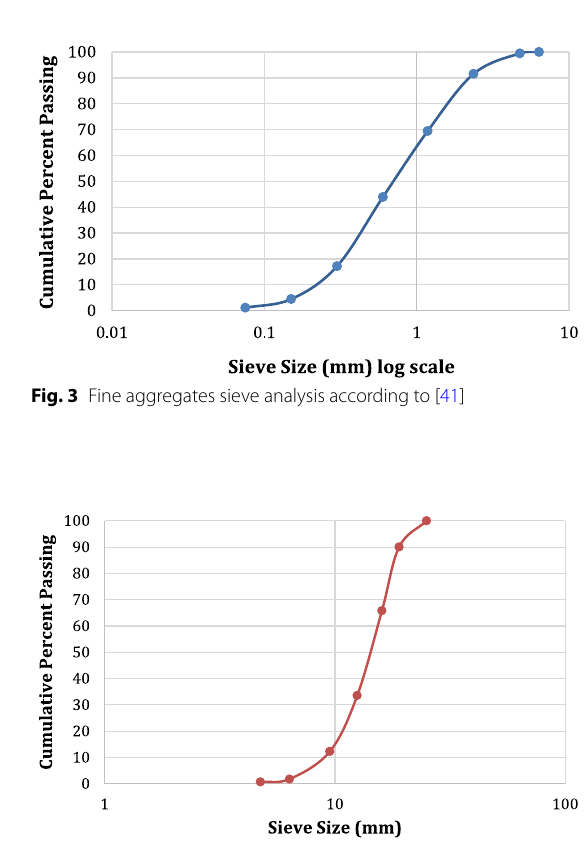
Fig. 4 Basalt sieve analysis according to [41]